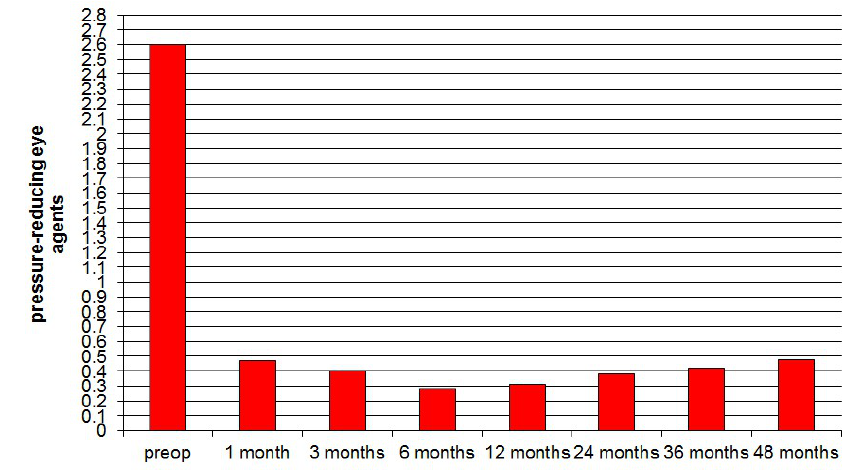
Figure 8. Progression of pressure-reducing eye agents pre-and postoperative during the 48 months, showing a marked and sustained postoperative reduction in numbers of agents needed.